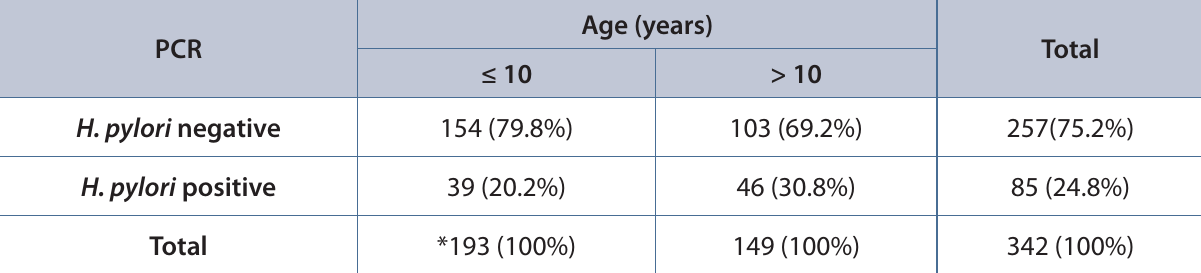
Table 1. Detection of Helicobacter pylori by PCR and its possible association with the age of patients